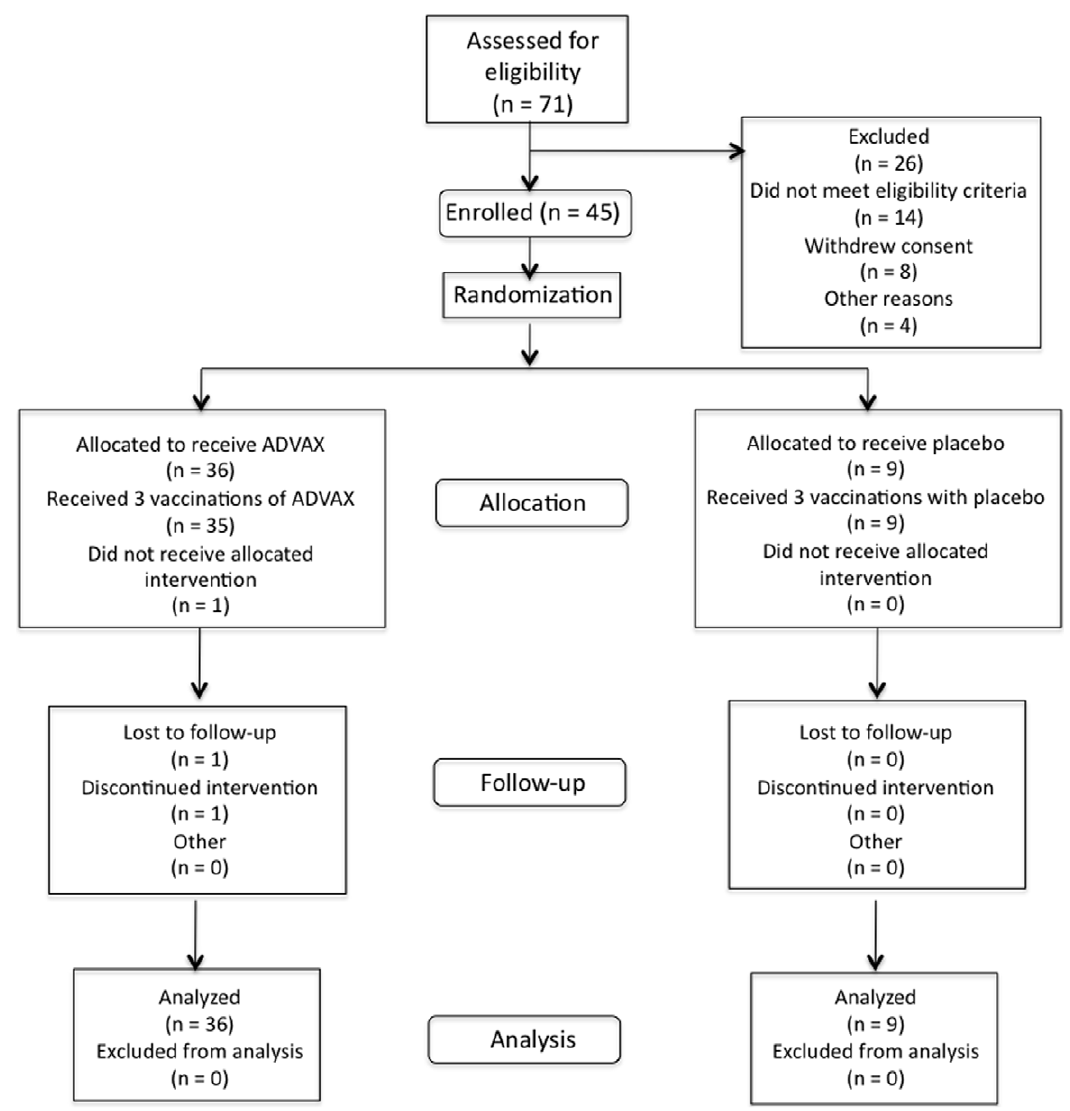
Figure 1. Clinical Trial Participant Flow Diagram.